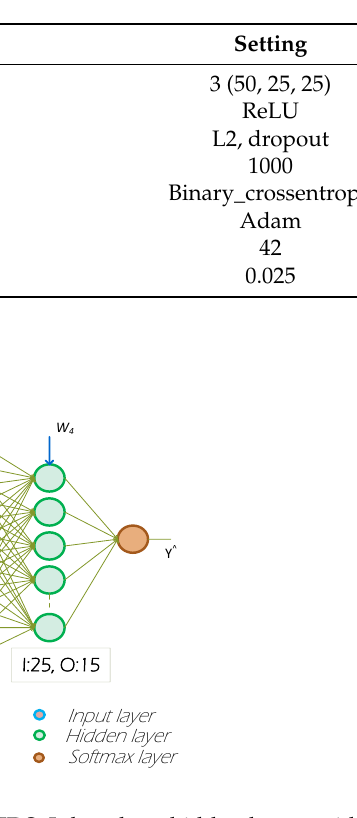
Figure 4. DNN architecture for the proposed IDS. It has three hidden layers with softmax as the output